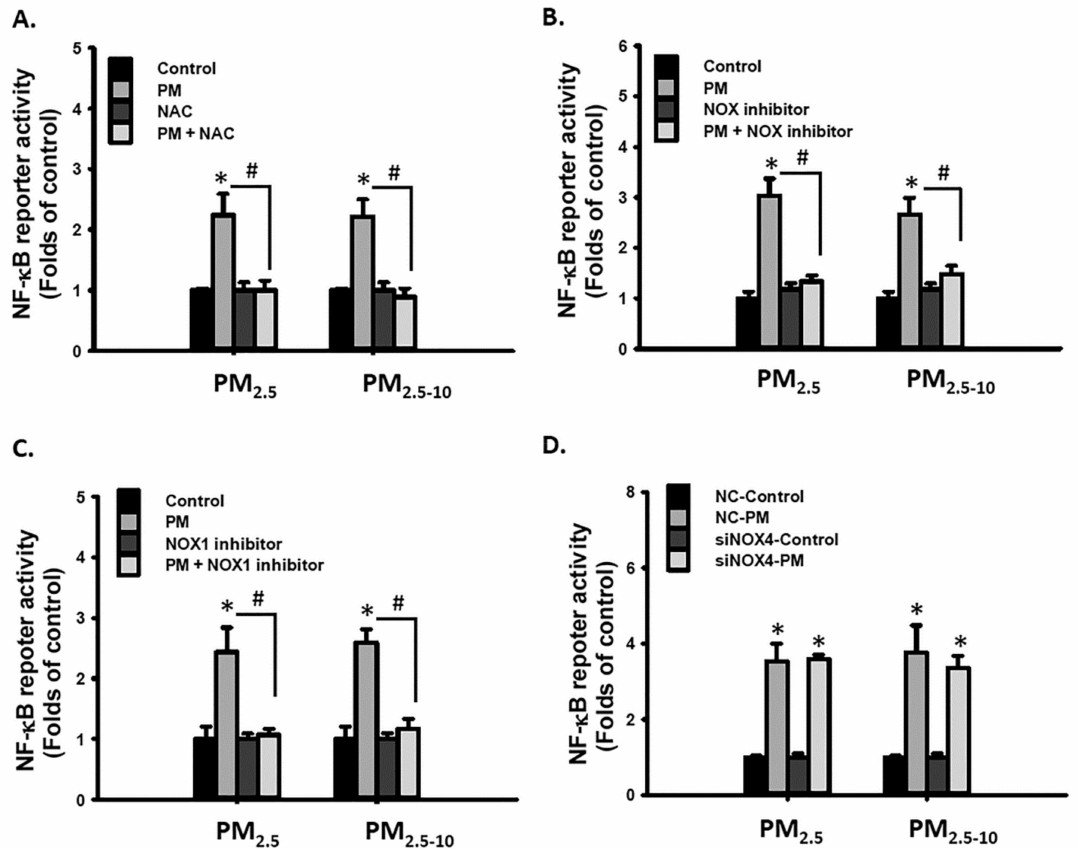
Figure 7. PM 2.5 and PM 2.5-10 activated the NOX1/ROS/NF- κ B signaling pathway in MVSMCs. MVSMCs were treated with d 2 H 2 O or 25 µ g/mL PM 2.5 or PM 2.5-10 with and without ( A ) 10 µ M NAC, ( B ) 10 µ M NOX inhibitor, and ( C ) 10 µ M NOX1 inhibitor. ( D ) MVSMCs were transfected with NC-RNA or siNOX4 RNA. Transfected MVSMCs were treated with d 2 H 2 O or 25 µ g/mL PM 2.5 or PM 2.5-10. The NF- κ B reporter activity was measured after treatment for 48 h. The results are presented as the mean ± SD for four independent experiments. * p < 0.05, compared with vehicle-treated cells. # p < 0.05, compared with inhibitor-treated cells. Con: d 2 H 2 O treatment as control; NC: negative control for